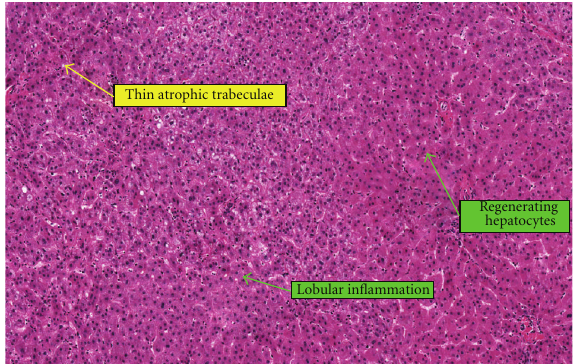
Figure 2: Histomicrograph of explanted